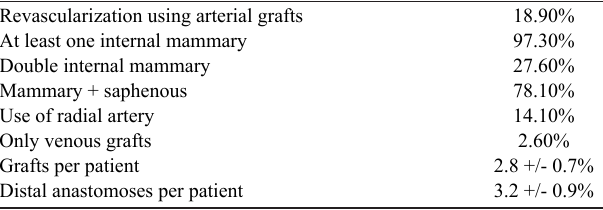
Table 4. 5-years results of SYNTAX trial on three-vessels